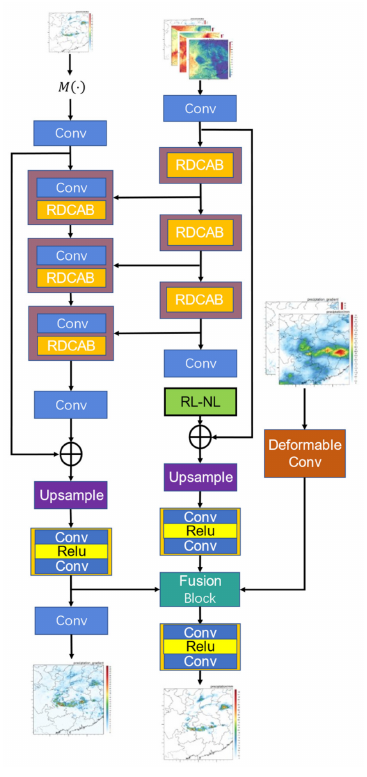
Figure 7. Architecture of the proposed